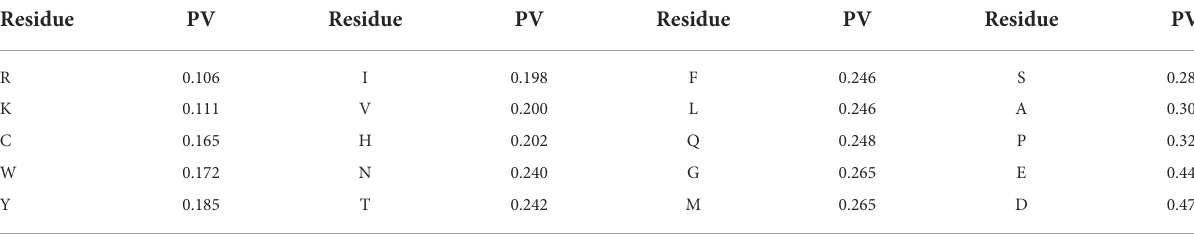
TABLE 3 Bactericidal propensity values (PV) for amino acid residues.